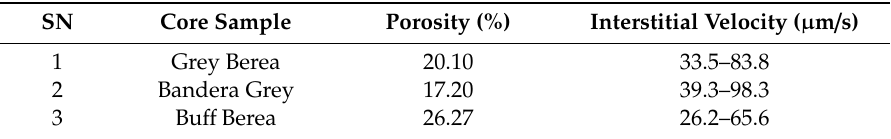
Table 4. Interstitial velocities employed in each core sample.